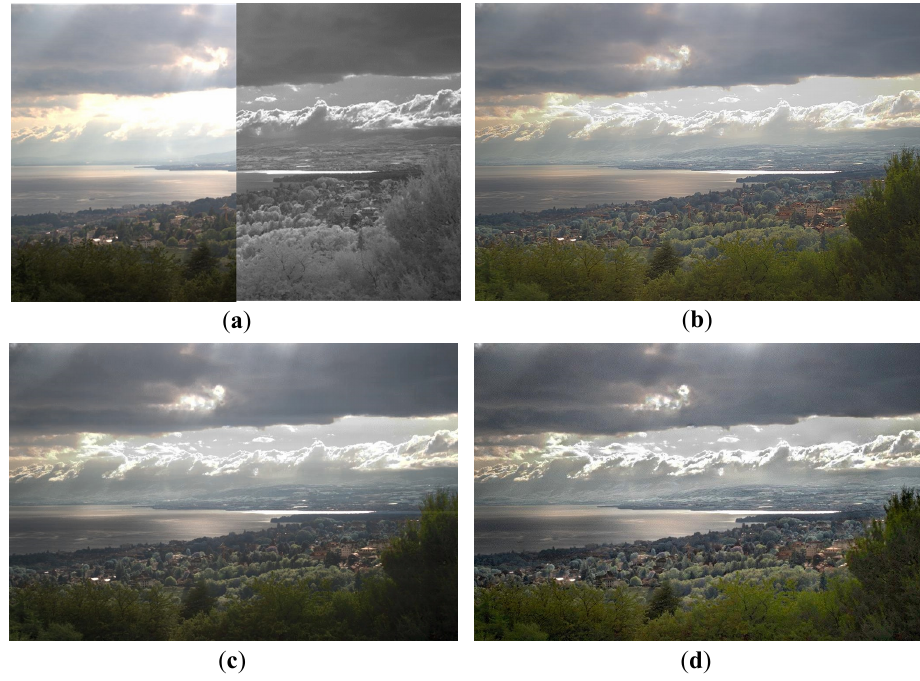
Figure 7. Input image pair and resulting images: ( a ) input VIS and near-infrared (NIR) images, (b) Laplacian pyramid fusion [1], (c) low-rank fusion [5], and (d) the proposed method.